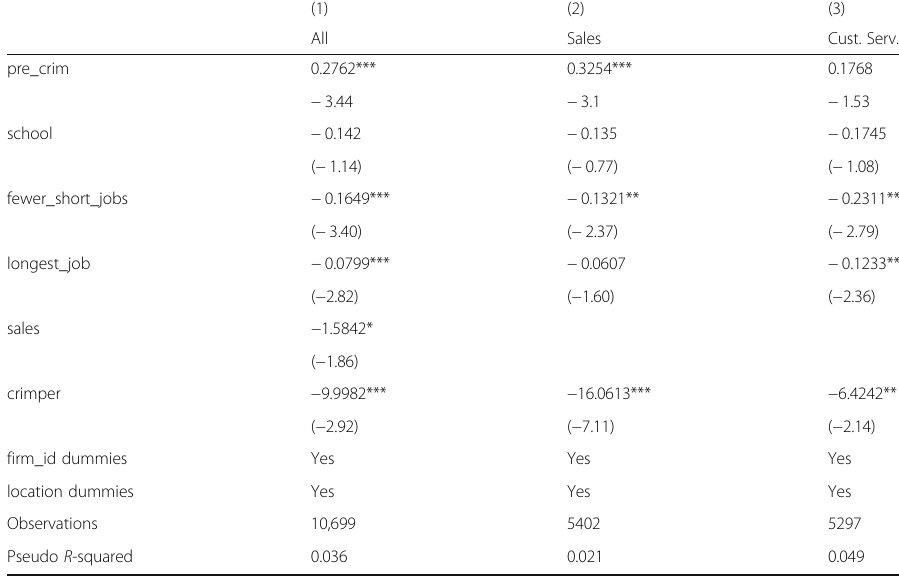
Table 8 Percent of employees with a criminal record as a correlate of misconduct, Cox Proportional Hazard